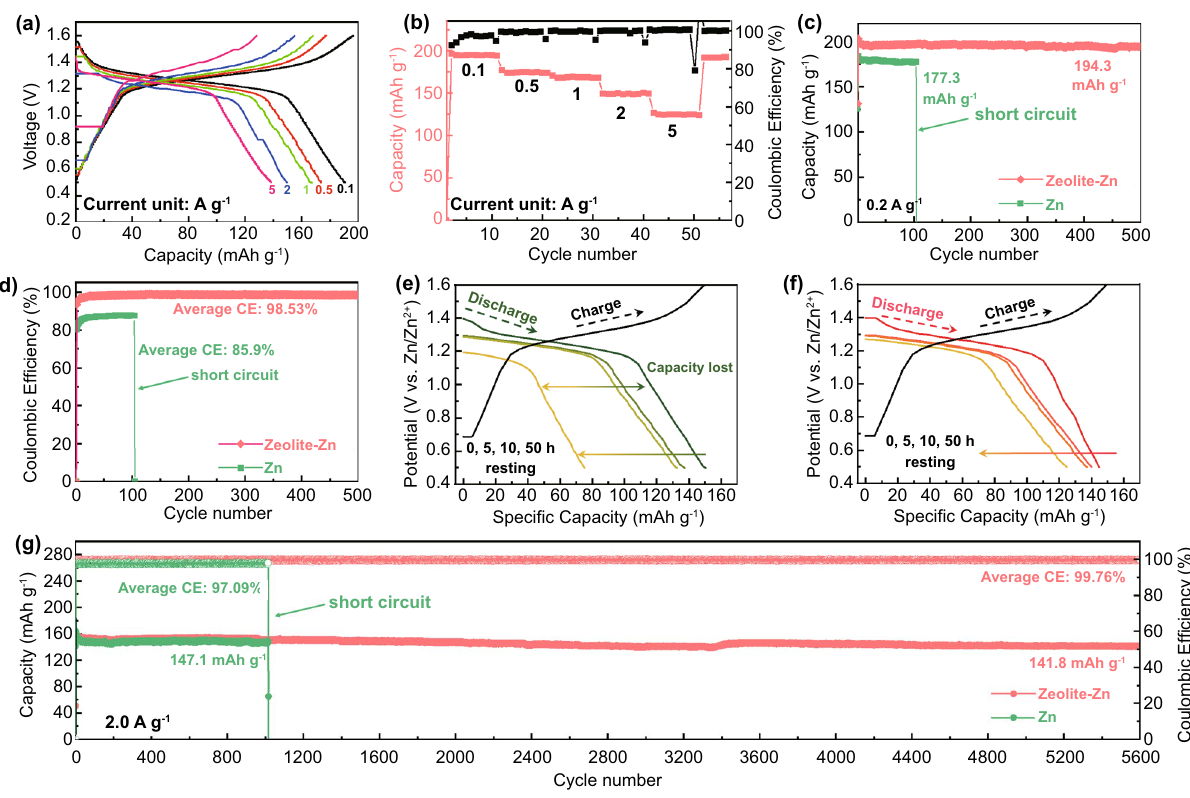
Fig. 4 a GCD curves and b rate performance of the Zeolite-Zn||I 2 battery. c Cycling performance and d Coulombic efficiencies (CEs) of the Zn||I 2 batteries with either bare- or Zeolite-Zn at 0.2 A g −1 . e – f Electrochemical aging test (static resting after fully charge state) of Zn||I 2 batter- ies with either bare-Zn or Zeolite-Zn anode. g Capacity and CE evolution of Zn||I 2 batteries at current density of 2 A g −1 with either bare-Zn or Zeolite-Zn